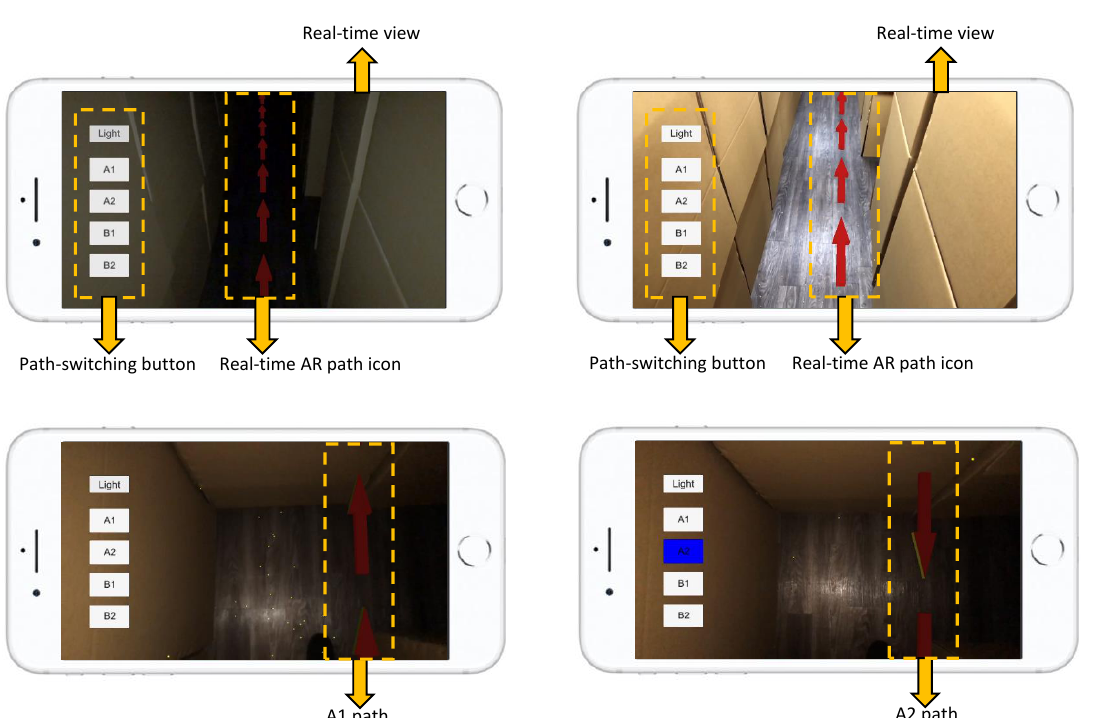
Figure 2. Screen shots of the MARINS interface in a dark environment ( top left ) and a bright environment ( top right ). The alternative path is selected by tapping the A2 option ( bottom ).